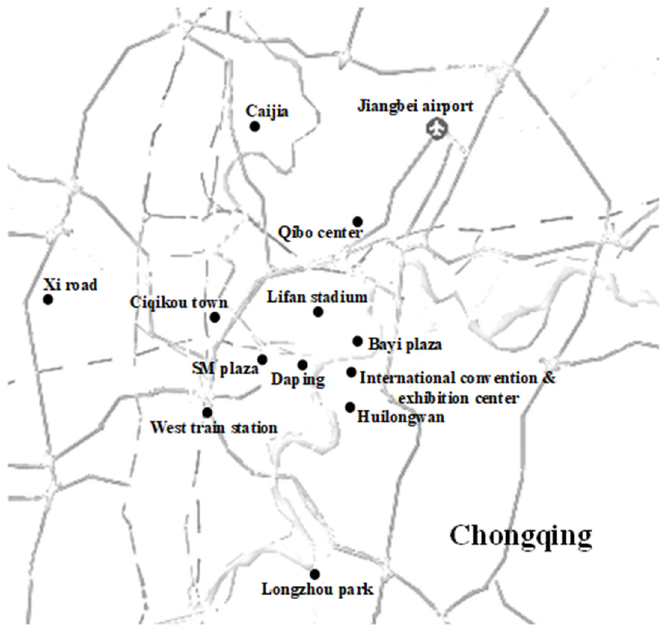
Figure 5. Investigation sites of China Auto Rental Inc. in Chongqing.